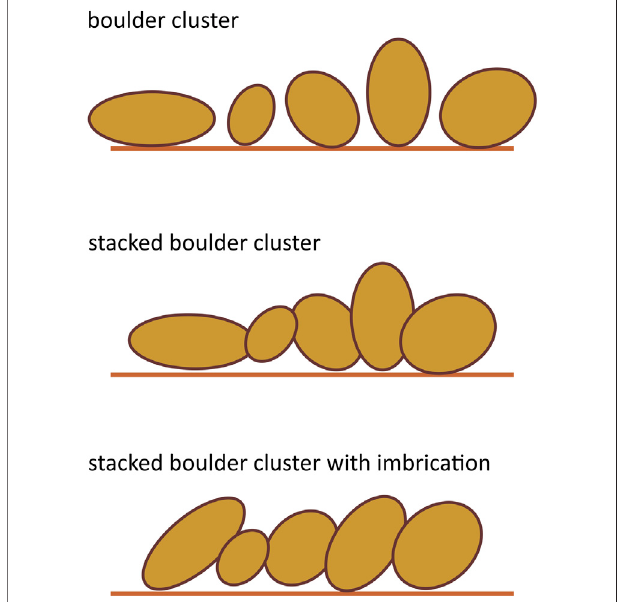
FIGURE 1 | Schematic diagram of a coastal boulder cluster, with or without stacking and imbrication of clasts.